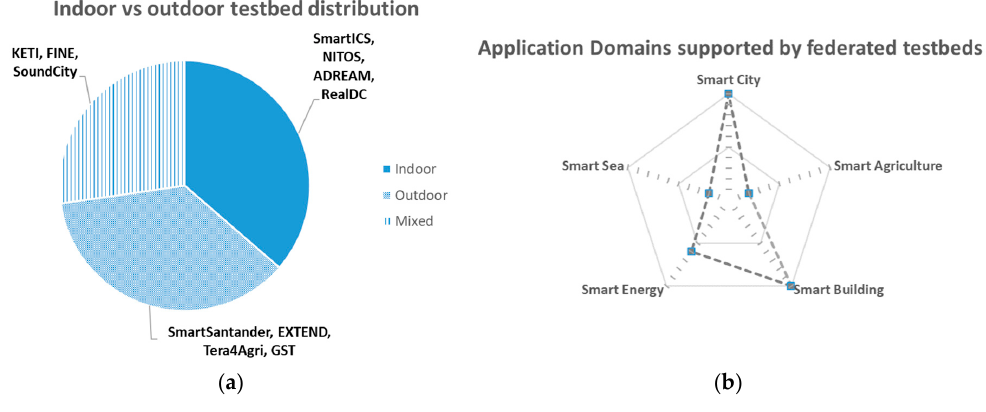
Figure 3. Application domains of the integrated sensors.